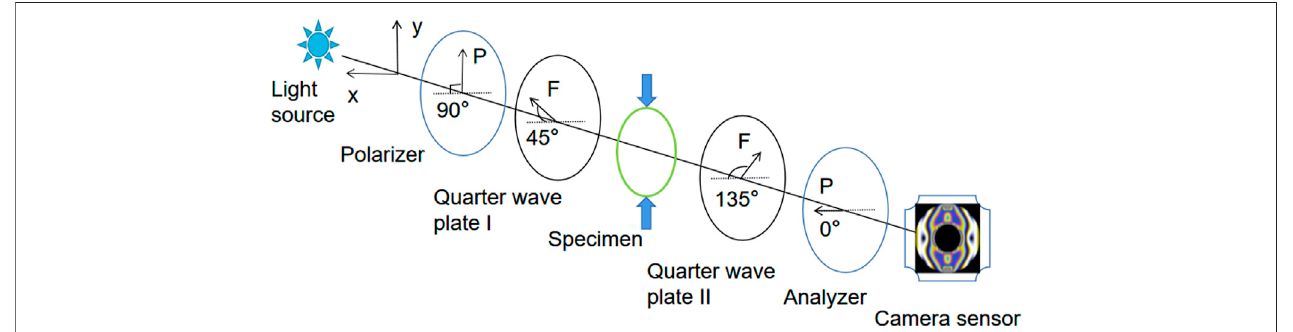
FIGURE 1 | Schematic diagram of the orthogonal circularly polarized light fi